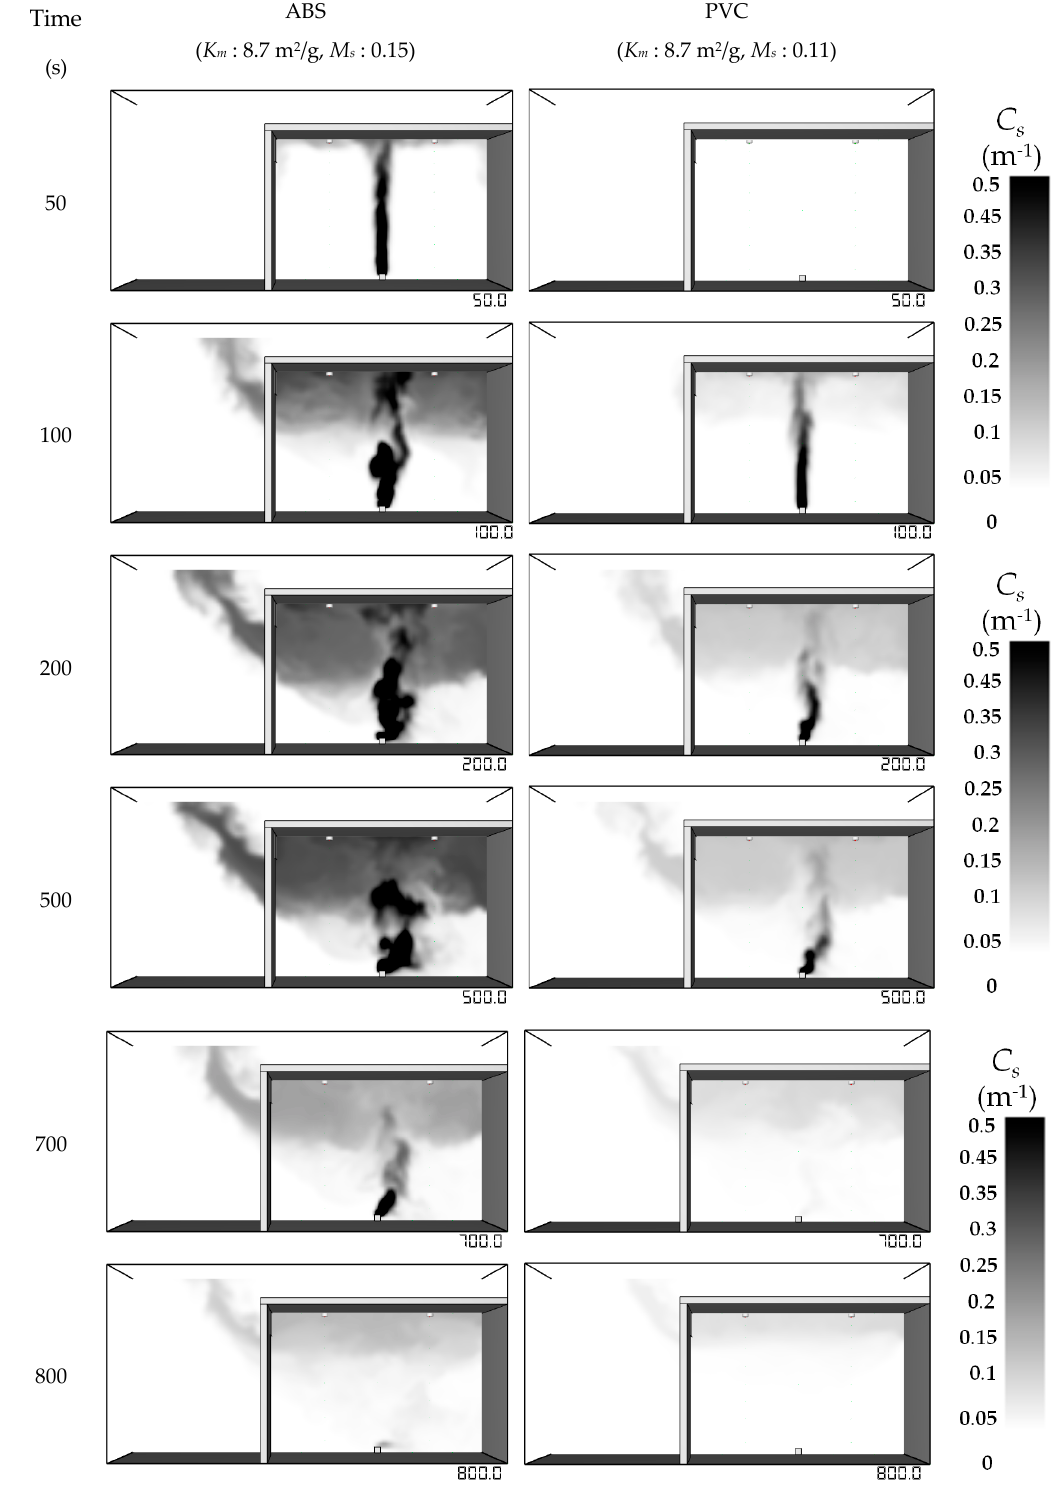
Figure 10. Calculated C s with the K m of 8.7 m 2 /g for both polymers as a function of time.